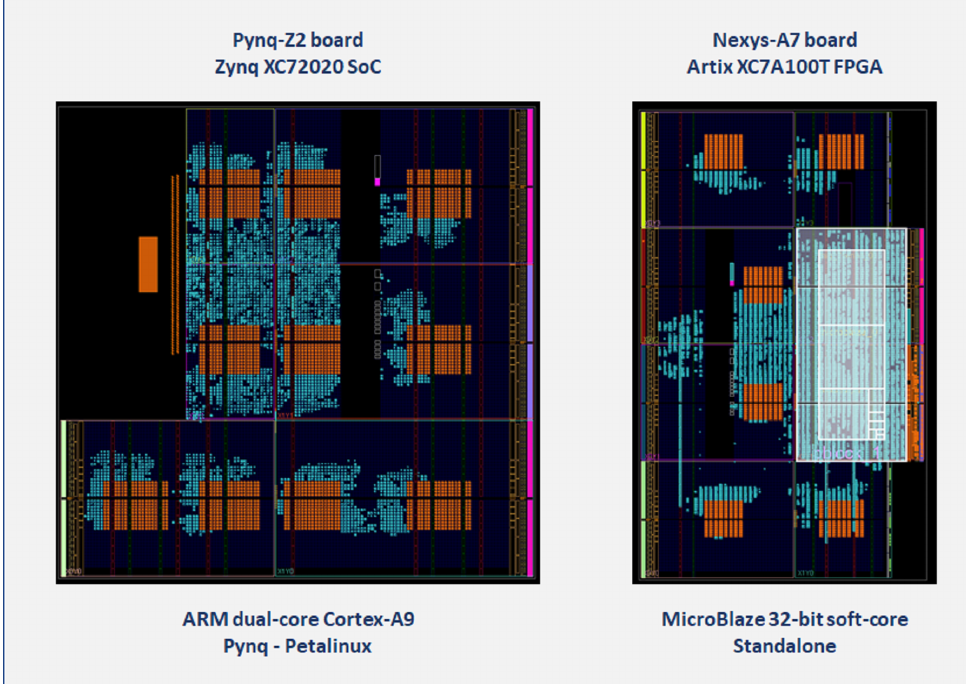
Figure 8. Device view of test system implementations in Pynq Z2 ( left ) and Nexys A7 ( right ) development